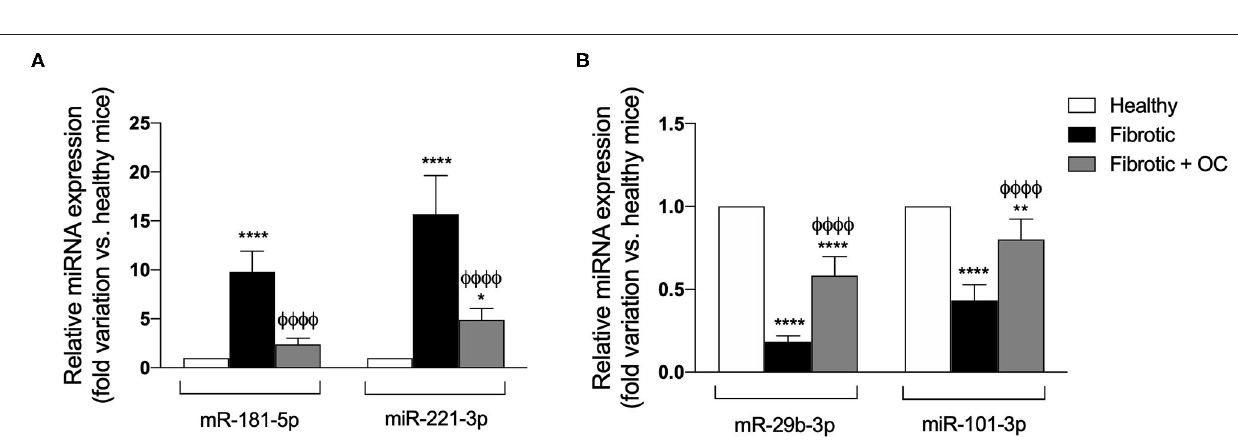
FIGURE 8 | Effect of OC on the hepatic expression of pro-fibrotic (A) and anti-fibrotic (B) miRNAs in a mouse model of fibrosis. * P < 0.05, ** P < 0.01, **** P < 0.0001 vs. control, φφφφ P < 0.0001 vs. fibrotic mice. Results are obtained by analyzing 6 animals per group in triplicate and have been analyzed by one-way ANOVA followed by the Tukey’s post hoc